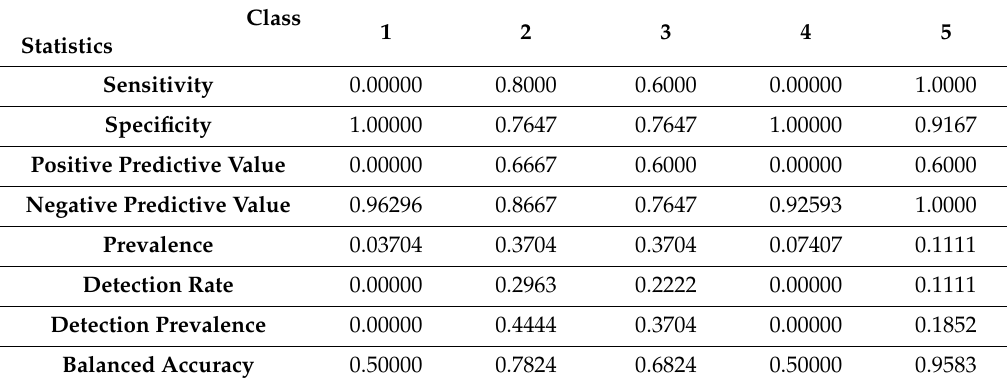
Table 1. Results of the naive Bayes